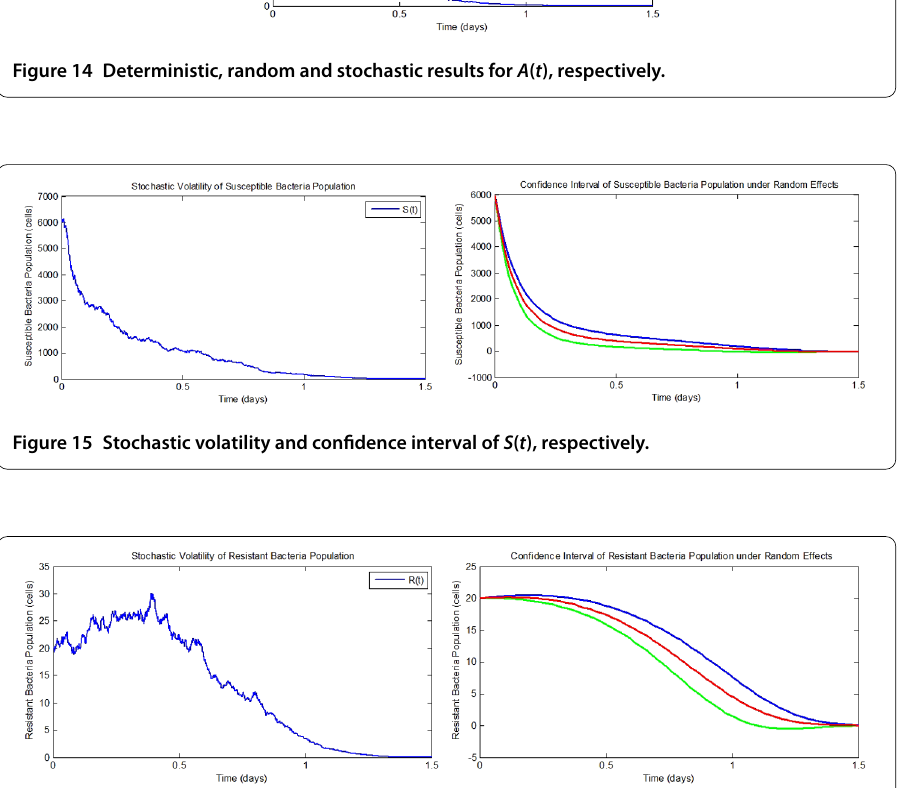
Figure 16 Stochastic volatility and confidence interval of R ( t ),